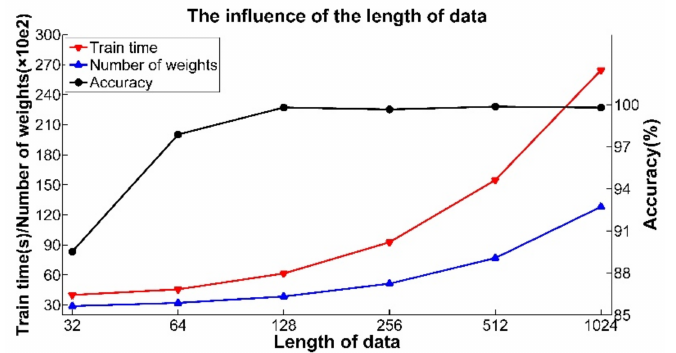
Figure 8. The influence of the length of data.